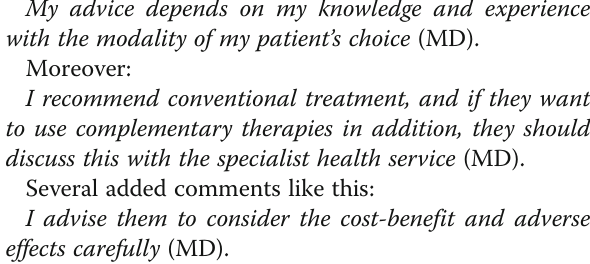
Moderately 219 (47.4)